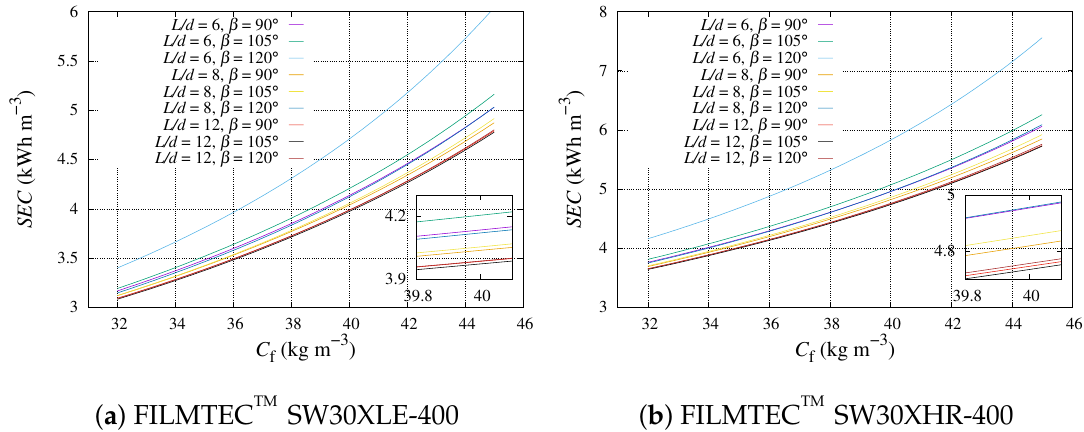
Figure 3. SEC of a PV with 8 SWMMs in series considering different FSGs, a range of C f , p f = 55 bar and Q f = 12 m 3 h − 1 .